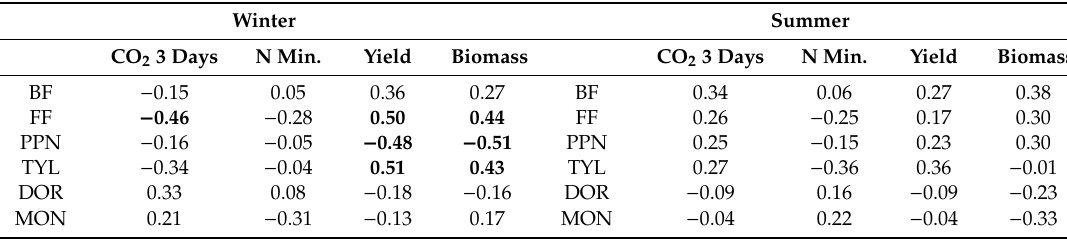
Table 5. Correlations between nematode trophic groups and soil health indicators in the winter (wheat) and summer (edamame) sampling